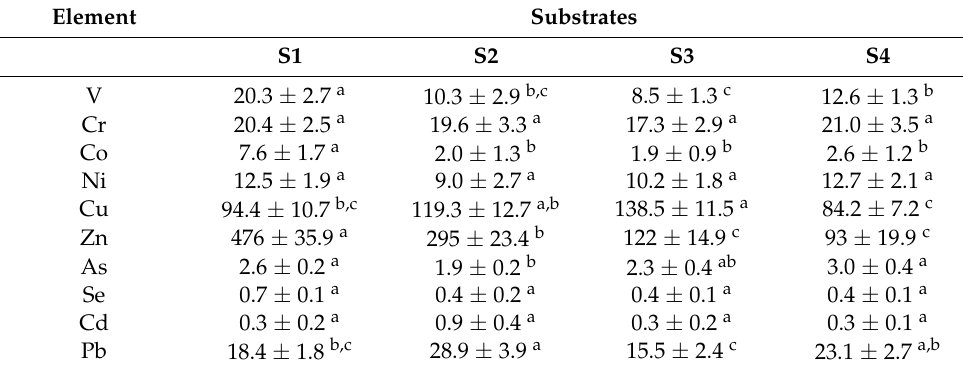
Table 2. Bioavailability of heavy metals and micronutrient in the four substrates (mg kg − 1 dry matter). Element